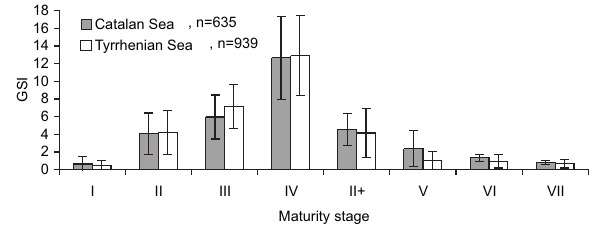
Fig . 5. – Merluccius merluccius mean female gonadosomatic index (GSI) for each maturity stage. Bars denote SD.